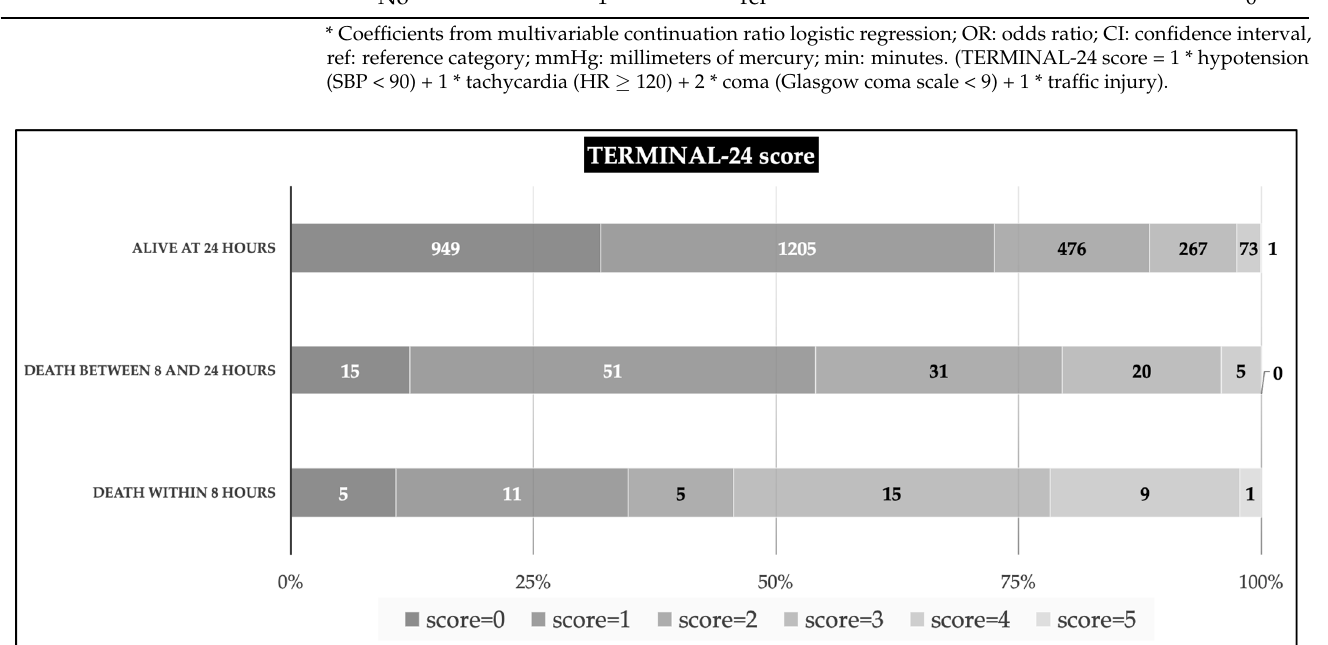
Figure 2. The distribution of TERMINAL-24 score by criterion-classified severity level; stacked bar charts with 0–100% bar for median/IQR (at 25%, 50%, and 75%); for each outcome group; the number in the bar chart represents the number of patients.